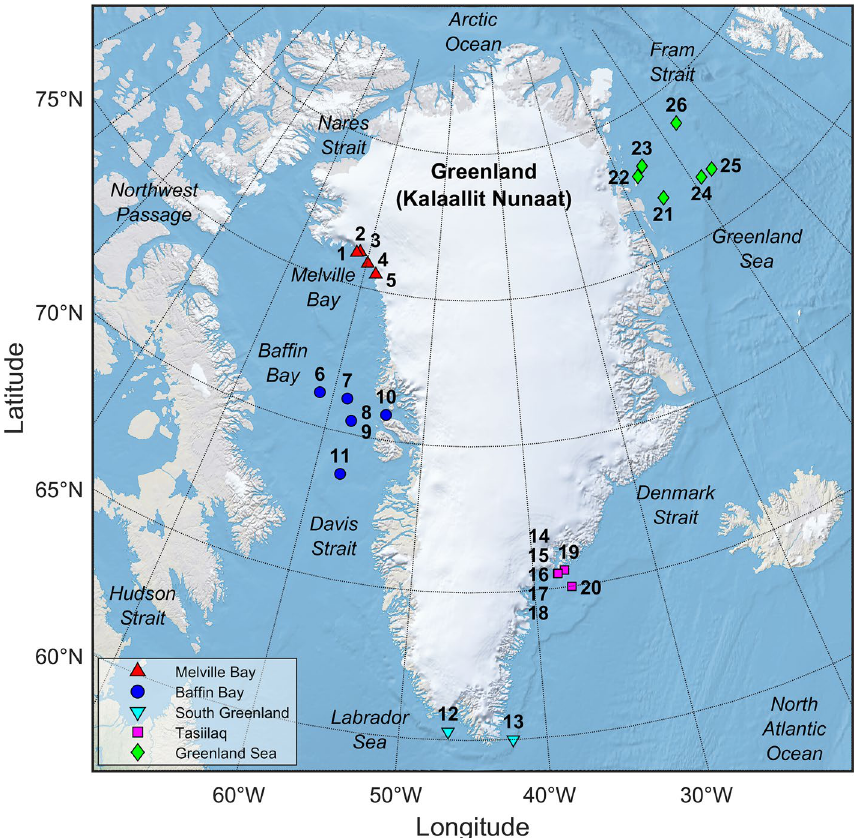
Figure 1. Map of recording locations. The stations (n = 26) are grouped into five regions. Melville Bay: red upwards pointing triangles, Baffin Bay: blue circles, South Greenland: cyan downwards pointing triangles, Tasiilaq: magenta squares, Greenland Sea: green diamonds. For stations 2 and 3, 8 and 9 and 14–18, only a single symbol is visible due to close proximity between locations. This figure was generated using MATLAB including functions such as readgeoraster, axesm and geoshow from the MATLAB Mapping Toolbox (Version 4.10, https:// se. mathw orks. com/ produ cts/ mappi ng. html). The raster map data was obtained from the Natural Earth website (“Natural Earth I with Shaded Relief, Water, and Drainages”, scale 1:10 m, version 3.2.0, www. natur alear thdata.